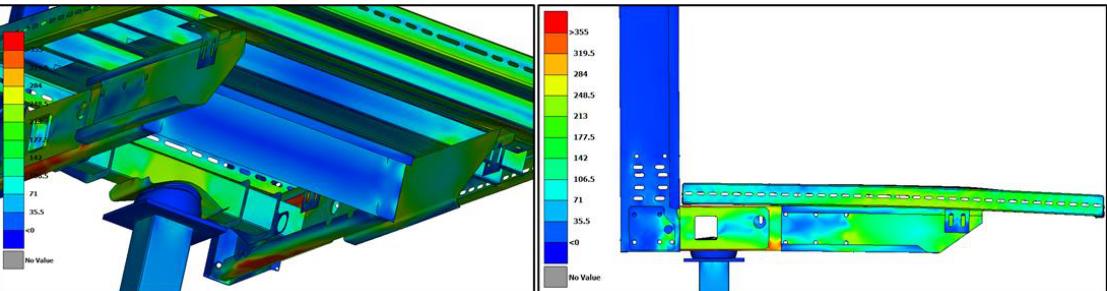
Figure 13. Von-Mises stress distribution on new-design elevator chassis for 6 mm settlement plate thickness.